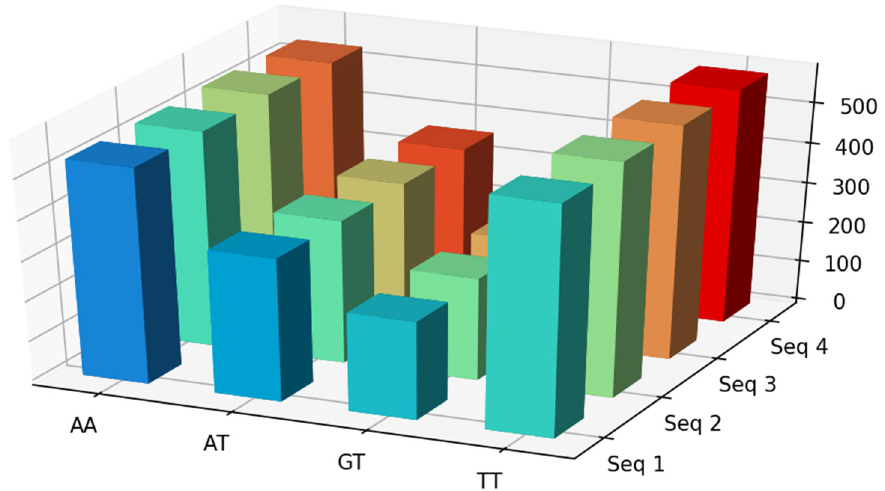
Figure 5. Visualization of first four sequences with substrings AA, AT, GT, and TT. In this example, we used frequencies as the computation method.